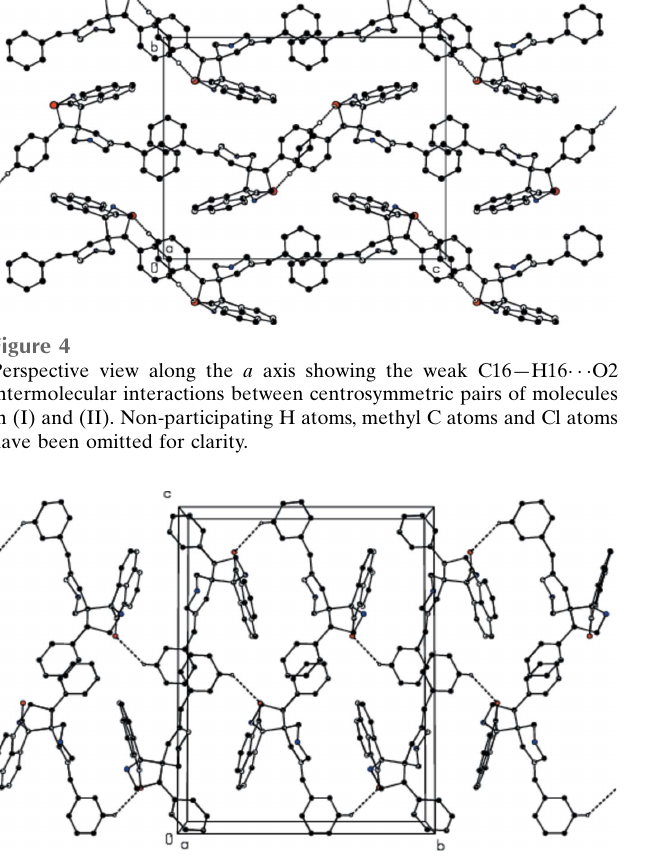
Figure 5 Perspective view along the a axis showing the weak C10—H10 (cid:2)(cid:2)(cid:2) O2 intermolecular interactions between glide-related molecules in (I) and (II). Non-participating H atoms, methyl C atoms and Cl atoms have been omitted for clarity.